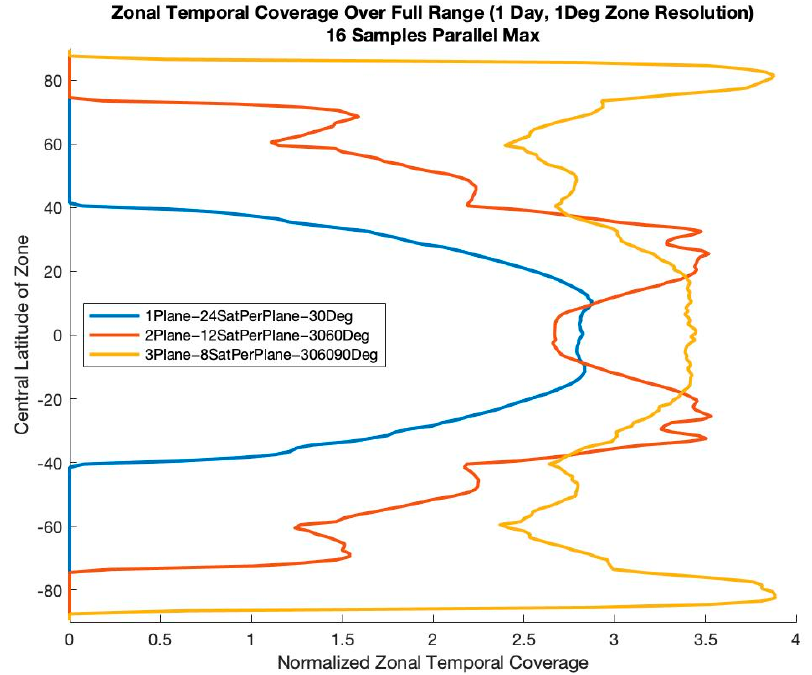
Figure 7. 24 h Temporal Coverage measurements at different latitudes for 24-satellite constellations at 800 km, 16 parallel measurements per sampling, and operating with an RCG Threshold of 15. As the initial 30° inclination plane of 24 satellites is divided in smaller planes with raised inclinations allows the constellation’s Zonal and Global Temporal Coverage to be shaped and increased.